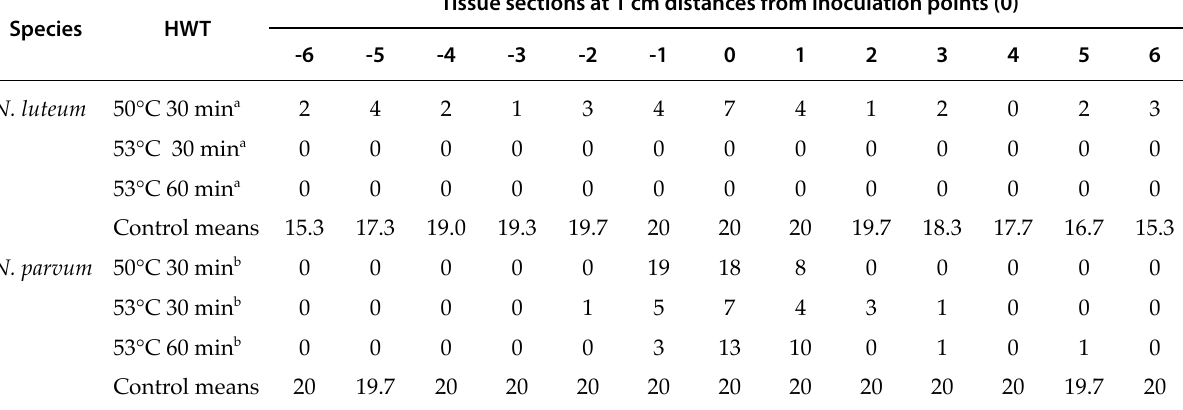
Table 3. Infection incidence (out of 20 replicates) of Neofusicoccum luteum and N. parvum in continuous positions along cane segments, with 0 indicating the inoculation point, negative numbers 1 cm sections below and positive numbers 1 cm sections above position 0. The different hot-water treatments (HWT) of the canes were applied 1 week after inoculation. Tissue sections at 1 cm distances from inoculation points (0) Species HWT N.